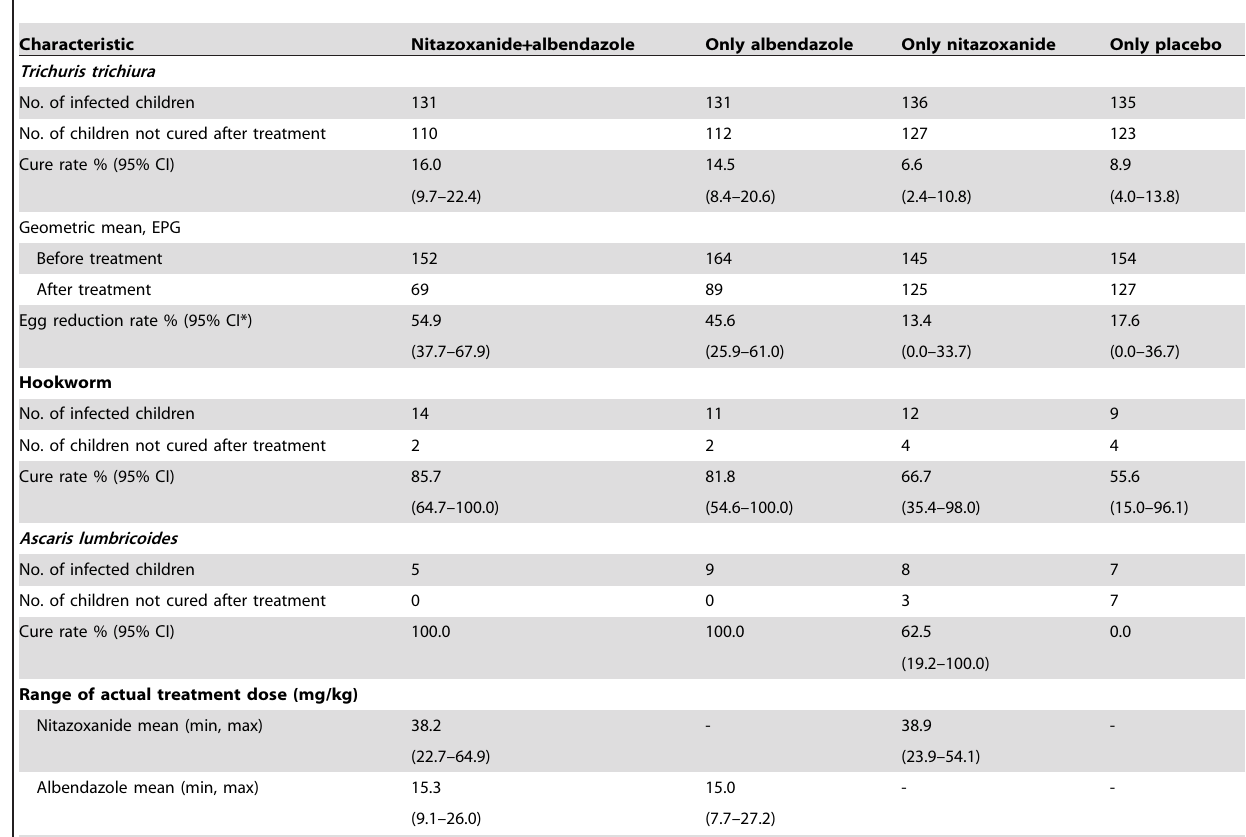
Table 2. Effect of albendazole, nitazoxanide, sequentially administered albendazole-nitazoxanide combination, and placebo against soil-transmitted